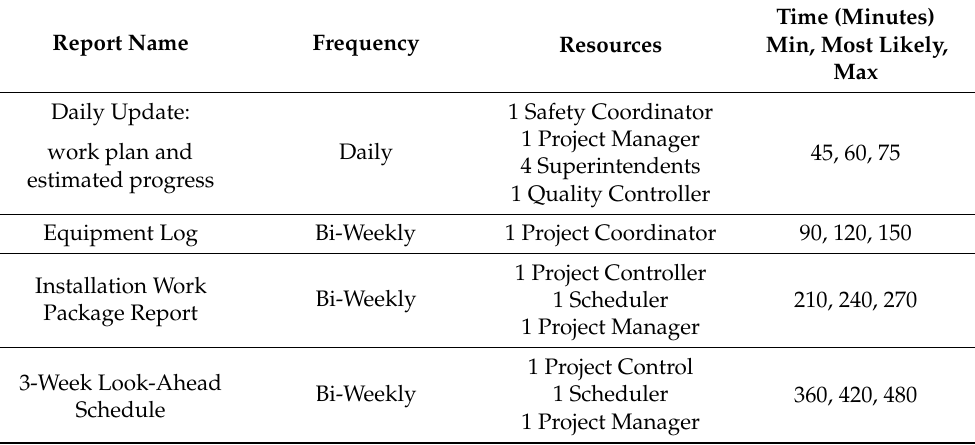
Table 5. Sample of report preparation-associated input